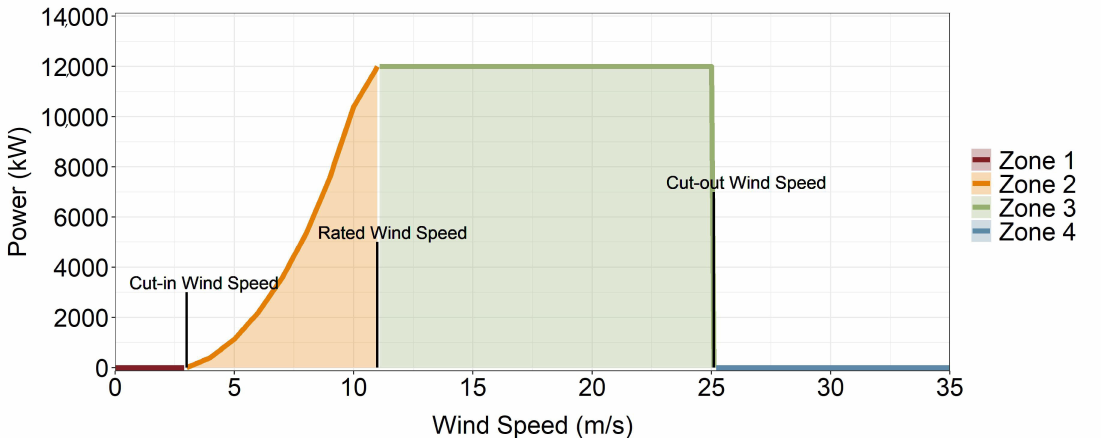
Figure 4. Power curve for a 12-MW turbine, adapted from Musial et al. [10]. The cut-in wind speed is 3 m / s, the rated wind speed is 11 m / s and the cut-out wind speed is 25 m /